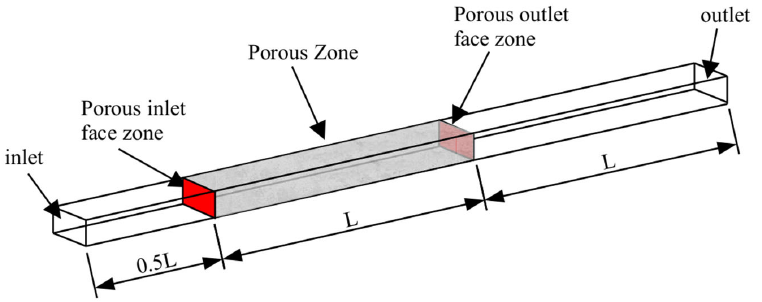
Figure 12. Computational setup for the porous model.